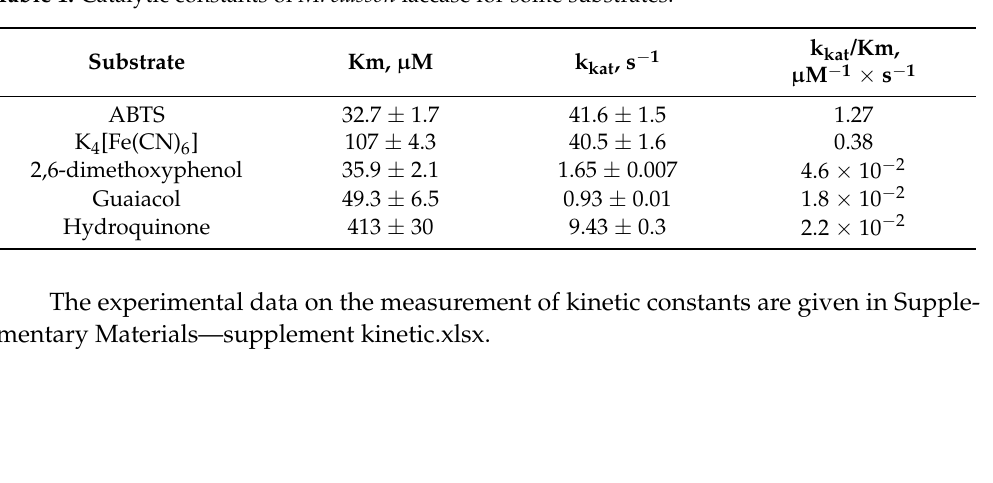
Figure 2. SDS-PAGE data of the purified M. elasson laccase preparation. Lane 1—laccase preparation, lane 2—molecular weight markers. Table 1. Catalytic constants of M. elasson laccase for some